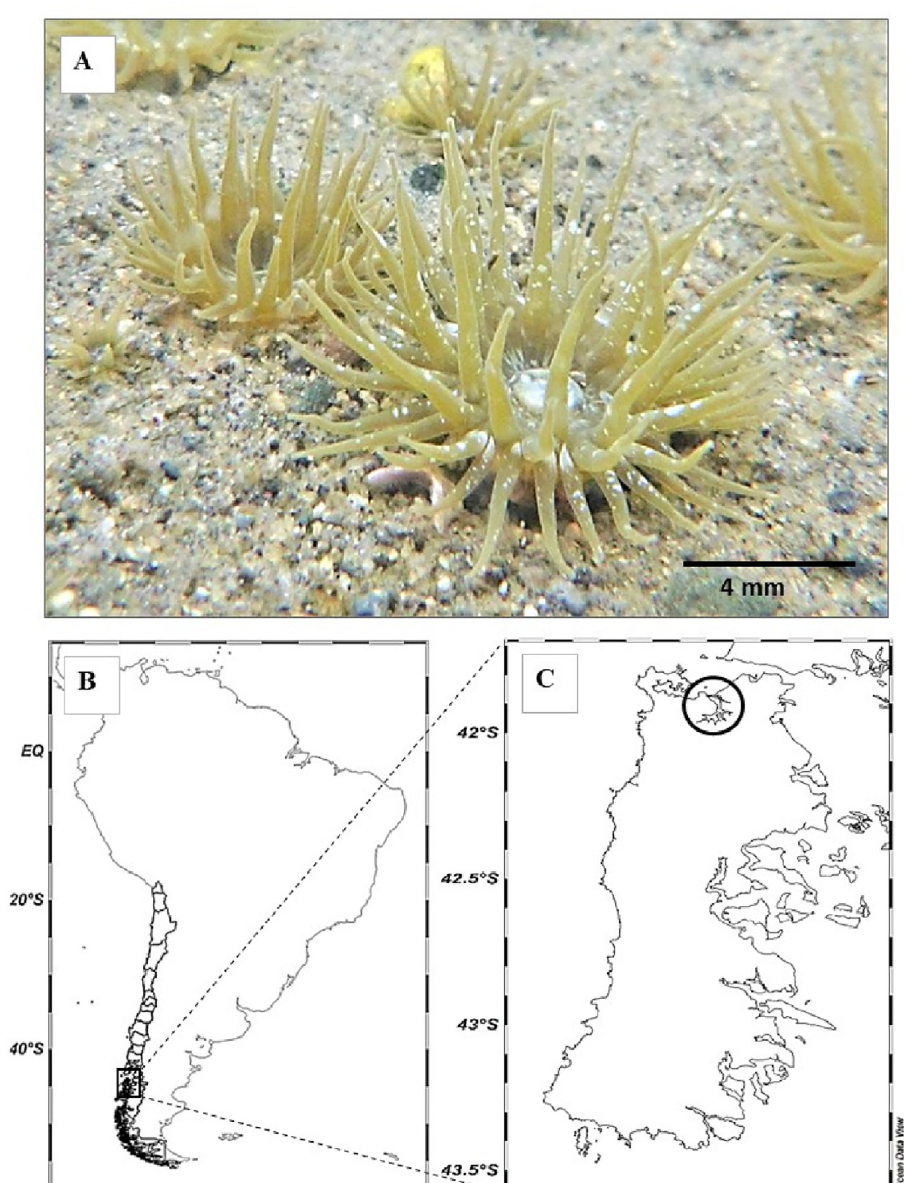
Fig 1. Anthopleura hermaphroditica . Adults of the estuarine anemone A . hermaphroditica (A) collected from southern Chile (Chiloe´ Island) (B) in the intertidal and subtidal areas of the Quempille´n estuary (C) (41˚520S; 73˚